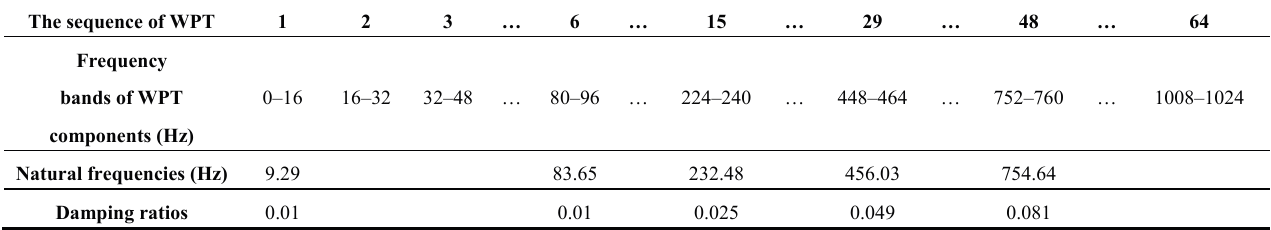
Figure 6. The relative energy distribution of the acceleration response for the undamaged case. Table 1. Frequency bands of the WPT components at level 6 and modal properties of the undamaged